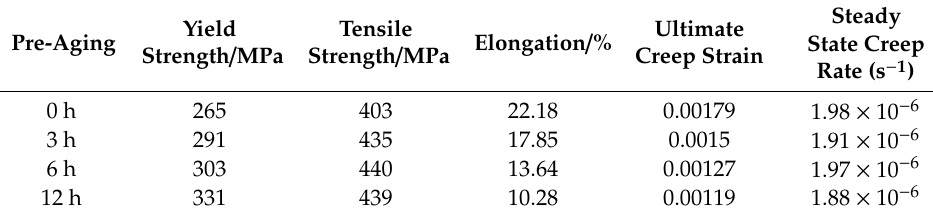
Figure 5. ( a ) Tensile stress–strain curves of the Al alloy as a function of pre-aging time; ( b ) creep strain–time curves of the alloy as a function of pre-aging time (elastic strain was removed). Table 2. Mechanical properties of the initial material with various pre-aging treatments.